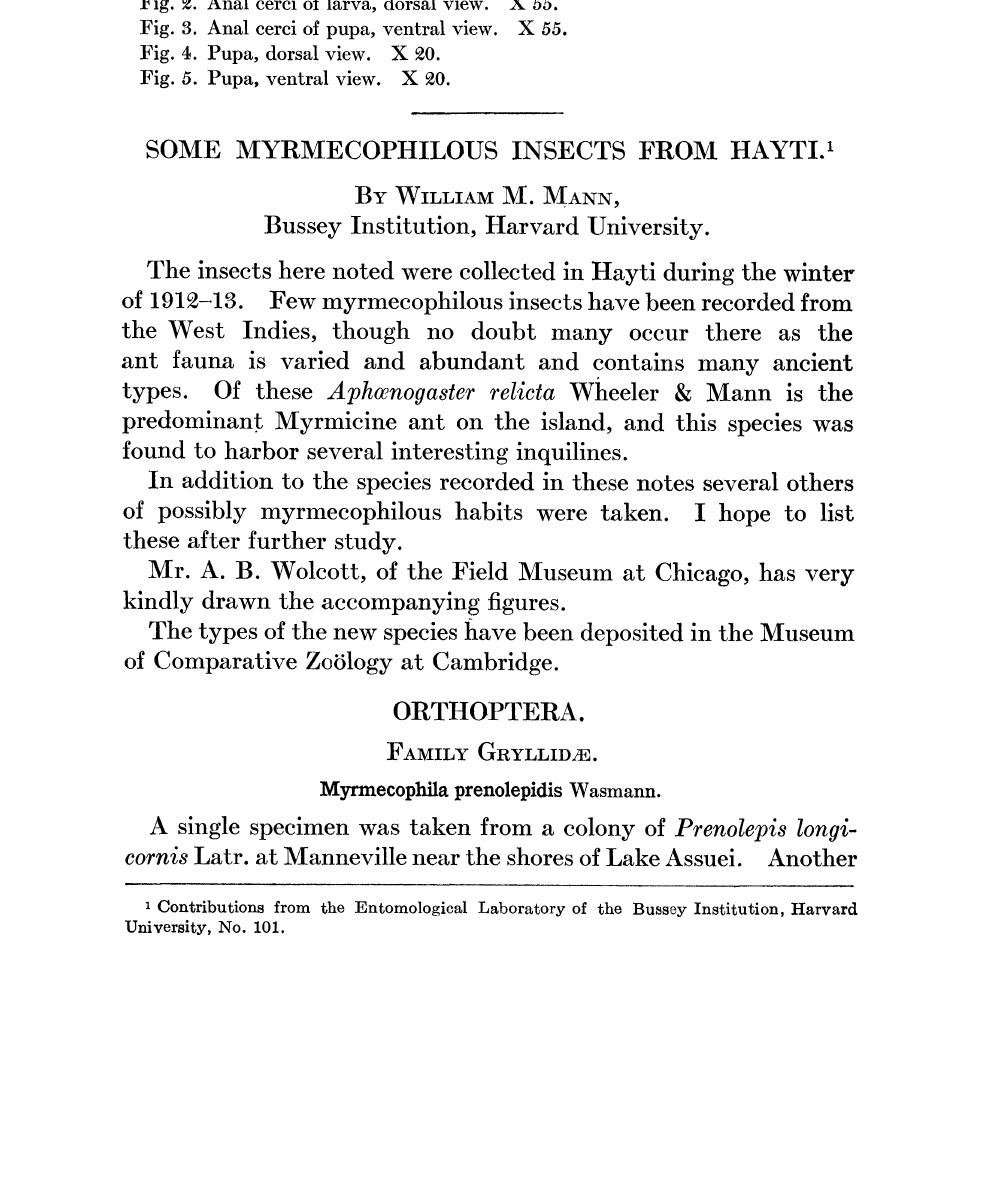
. Fig. 1. Head of larva, dorsal view. X 55. Head of larva, ventral view. X 55. Fig. . Fig. 1. Detail of antenna, larva, showing appendix. X 35. Anal cerci of larva, dorsal view. X 55. Fig. Fig. 3. Anal cerci of pupa, ventral view. X 55. Fig. 4. Pupa, dorsal view. X 0. Fig. 5. Pupa, ventral view. X